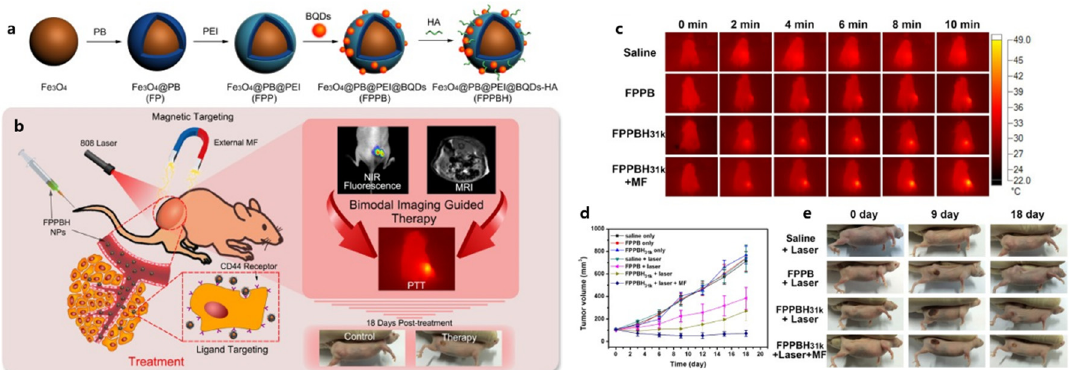
Figure 4. Schematic illustration of the ( a ) Fe 3 O 4 @PB@PEI@BQDs-HA (FPPBH) NPs fabrication procedure and ( b ) NIR fluorescence/MR bimodal imaging-guided cancer photothermal therapy (PTT) through intravenous injection. ( c ) Infrared thermal images of HeLa-bearing nude mice under the 808 nm laser irradiation taken at different time intervals. ( d ) Therapeutic effectiveness expressed as tumor volume in each group after treatment in HeLa-bearing nude mice. Data shown as mean SD, n = 8. ( e ) Photographs of representative mice of the four different groups taken before and after treatment for 9 and 18 days. Reproduced from reference [87], copyright open access by Ivyspring 2017.